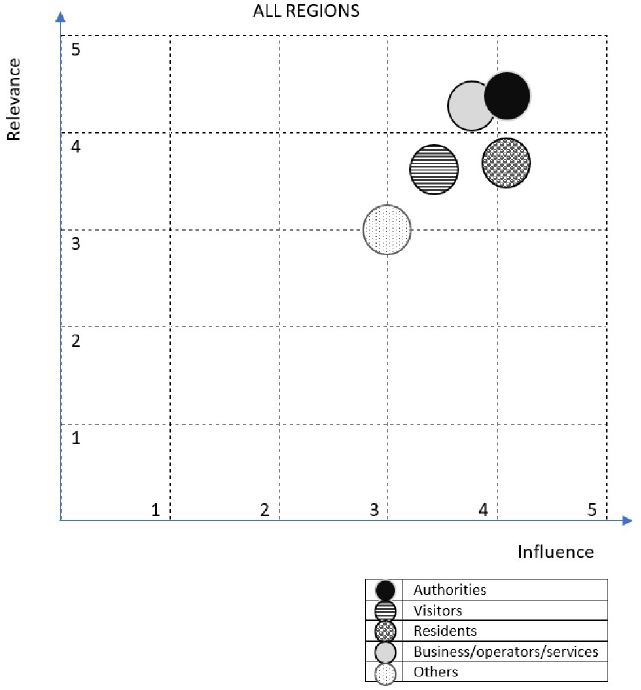
Fig 7. Average measures of the importance and relevance of individual stakeholder groups in addressing local mobility issues. Source: Own study.